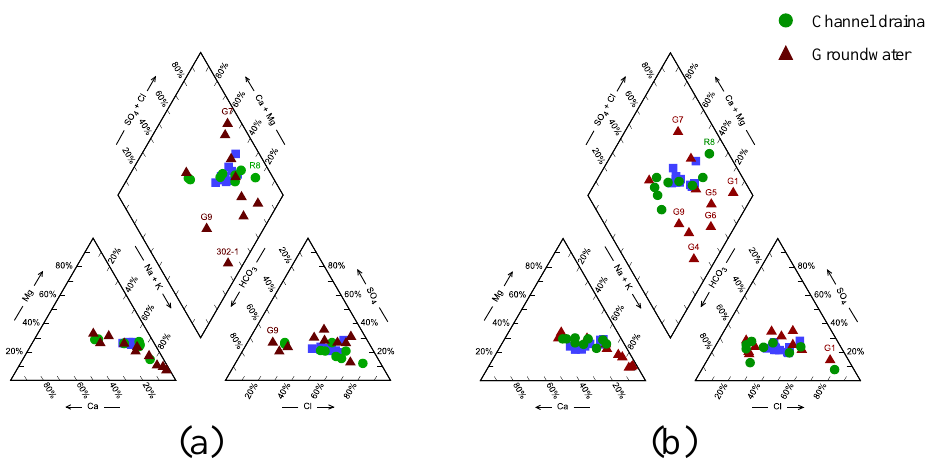
Figure 9. Piper diagram of the hydrochemical types in the three water bodies ( a ) in April 2021 and ( b ) in October 2021.